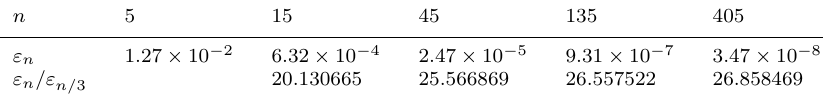
Table 6. Numerical results for f ( x ) = x 2 sgn x , x ∈ [ − 1 , 1] , uniform mesh, n even. n 8 16 32 ε n 4 . 39 × 10 − 3 ε n /ε n/ 2